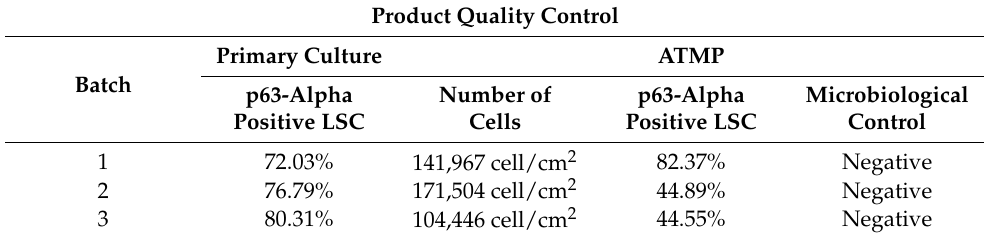
Figure 4. Phase-contrast microscopy (Scale: 75 µ m) and immunofluorescence analysis of the LSC primary cultures in which CK positive LSC appear red (Scale: 75 µ m), p63-alpha positive LSC appear green (Scale: 50 µ m) and DAPI appears blue. LSC: Limbal Stem Cell; CK: cytokeratin. Table 7. Product quality